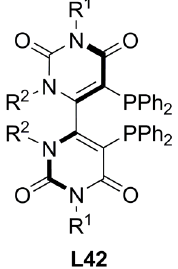
Figure 18. Chiral atropoisomeric bipyrimidinyl diphosphine.